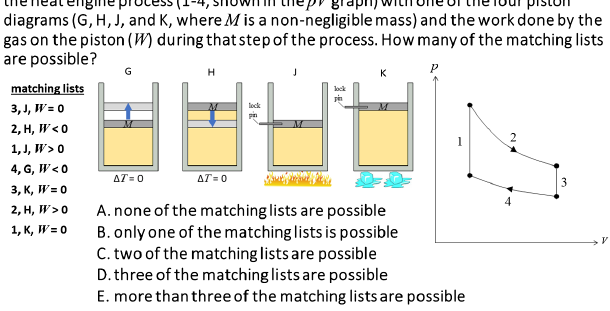
FIG. 4. A thermodynamics FIQ for a heat engine